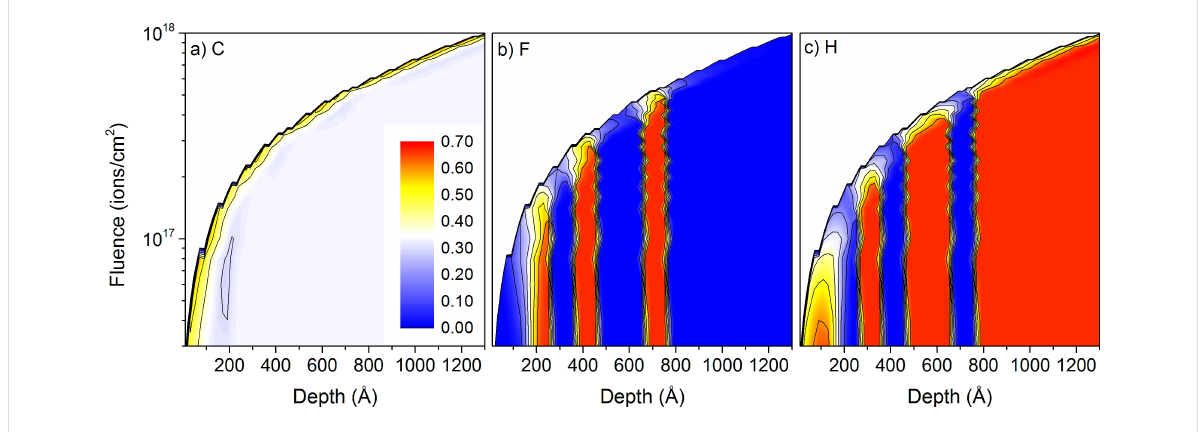
Figure 7: Sample composition as a function of depth and primary ion fluence for 1 keV Ne + irradiation of sample #1 with the thin-layer configuration: a) for carbon, b) for fluorine, and c) for hydrogen. The colour scale shows concentrations from 0 to 70% and is identical for all species.